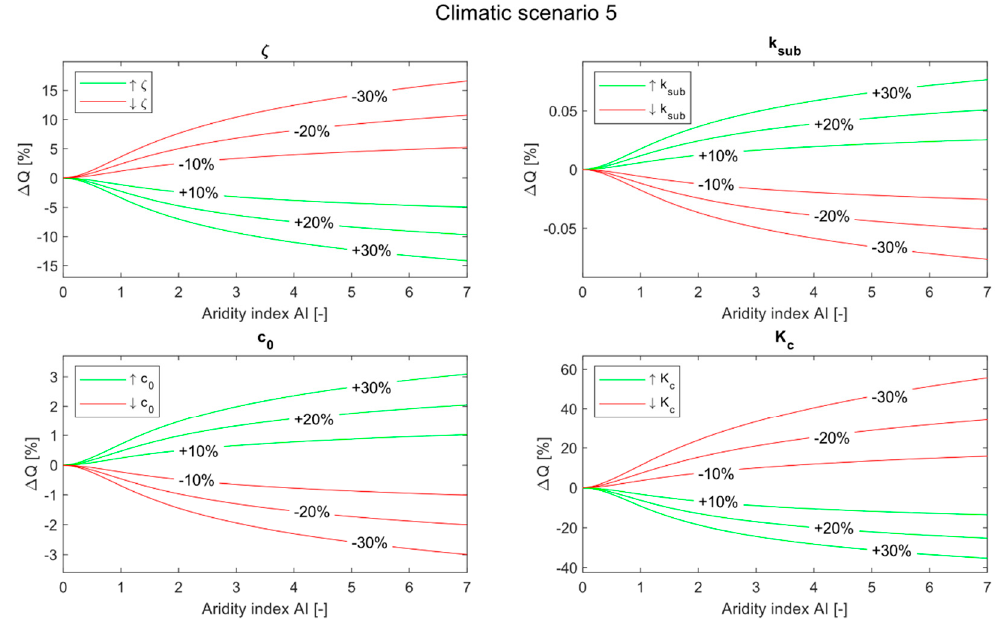
Figure 8. Runoff alteration, under different 𝐴𝐼 , referring to the climatic scenario 5 and supposing an increment/decrement of 10, 20, or 30 per cent of the four morphological and vegetation descriptors from the test-watershed configuration. The curves associated with positive alteration of the morphology and vegetation parameters are reported in green and the ones associated with negative variation are in red.